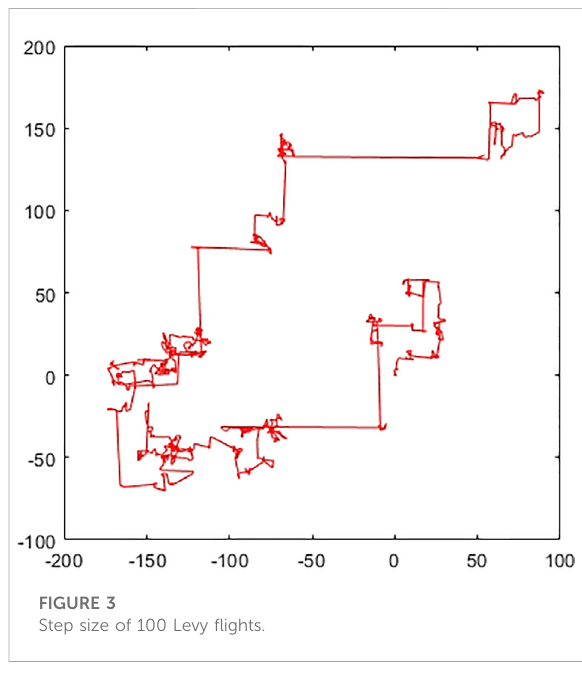
FIGURE 3 Step size of 100 Levy fl